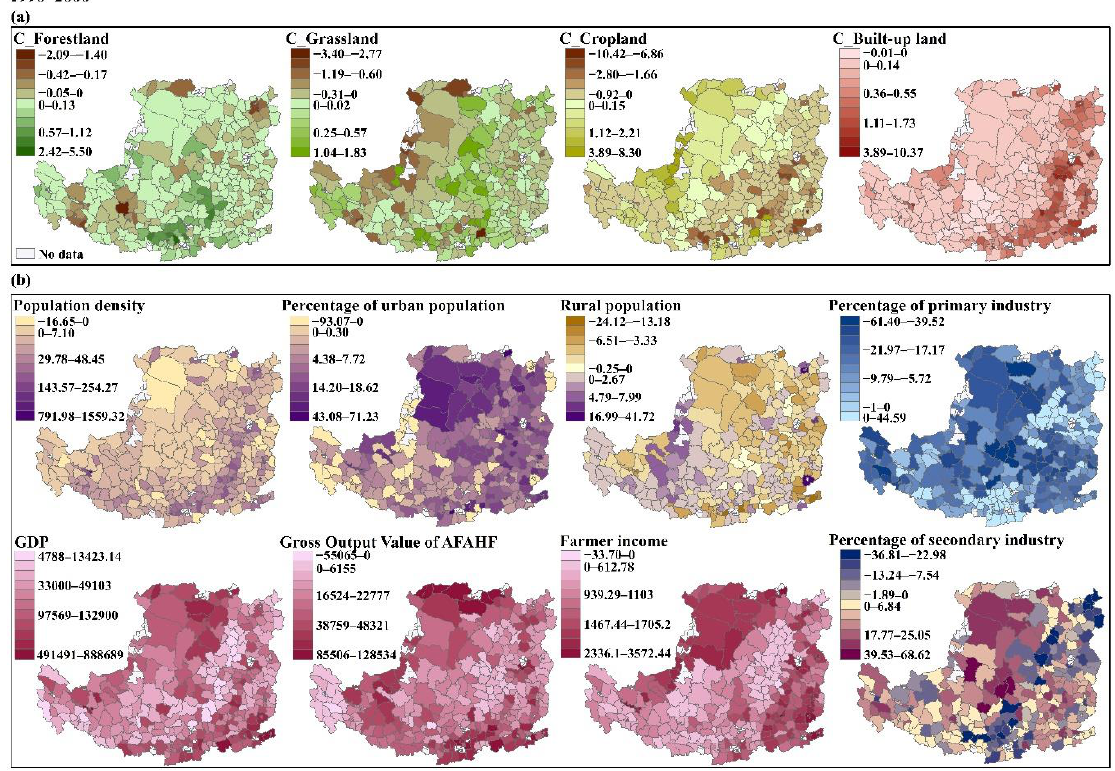
Figure 7. Changes of the four major land-use types ( a ) and multiple socioeconomic factors ( b ) from 1990 to 2000. C_Forest = changes of forestland percent from 1990 to 2000, the same holds for C_Grassland, C_Cropland and C_Built-up land; AFAHF = agriculture, forestry, animal husbandry and fishery.